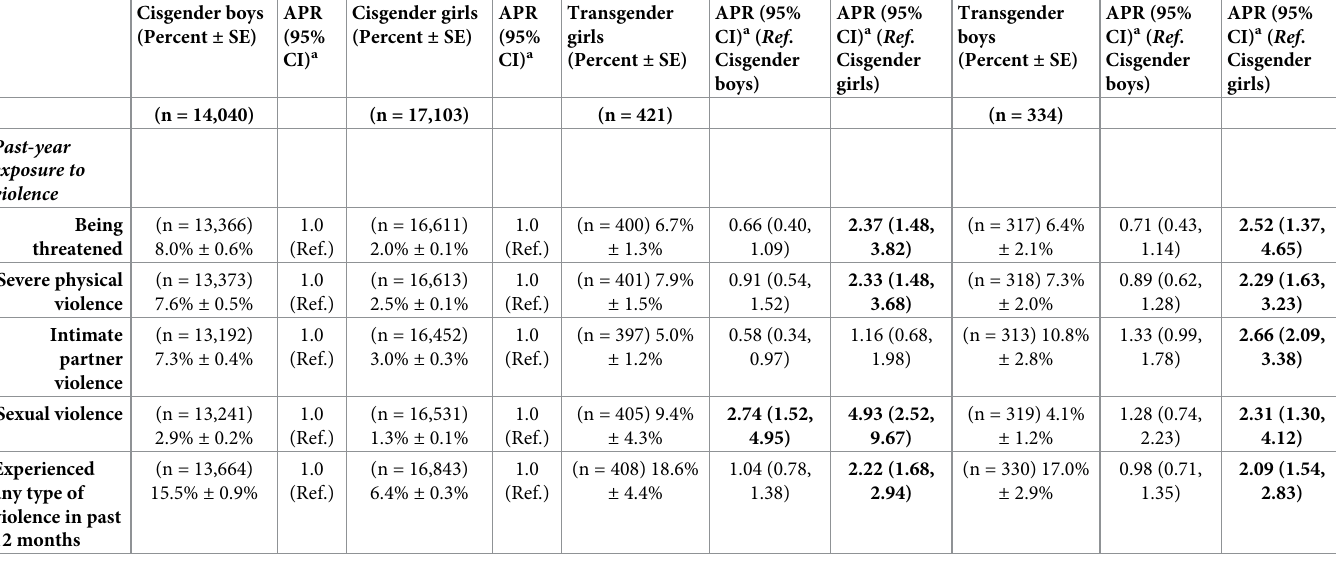
Table 4. Prevalence (weighted percent ± SE) and adjusted odds ratios (AORs) of past-year exposure to violence among respondents of the TSSHRBS, stratified by gender. Cisgender boys (Percent ±